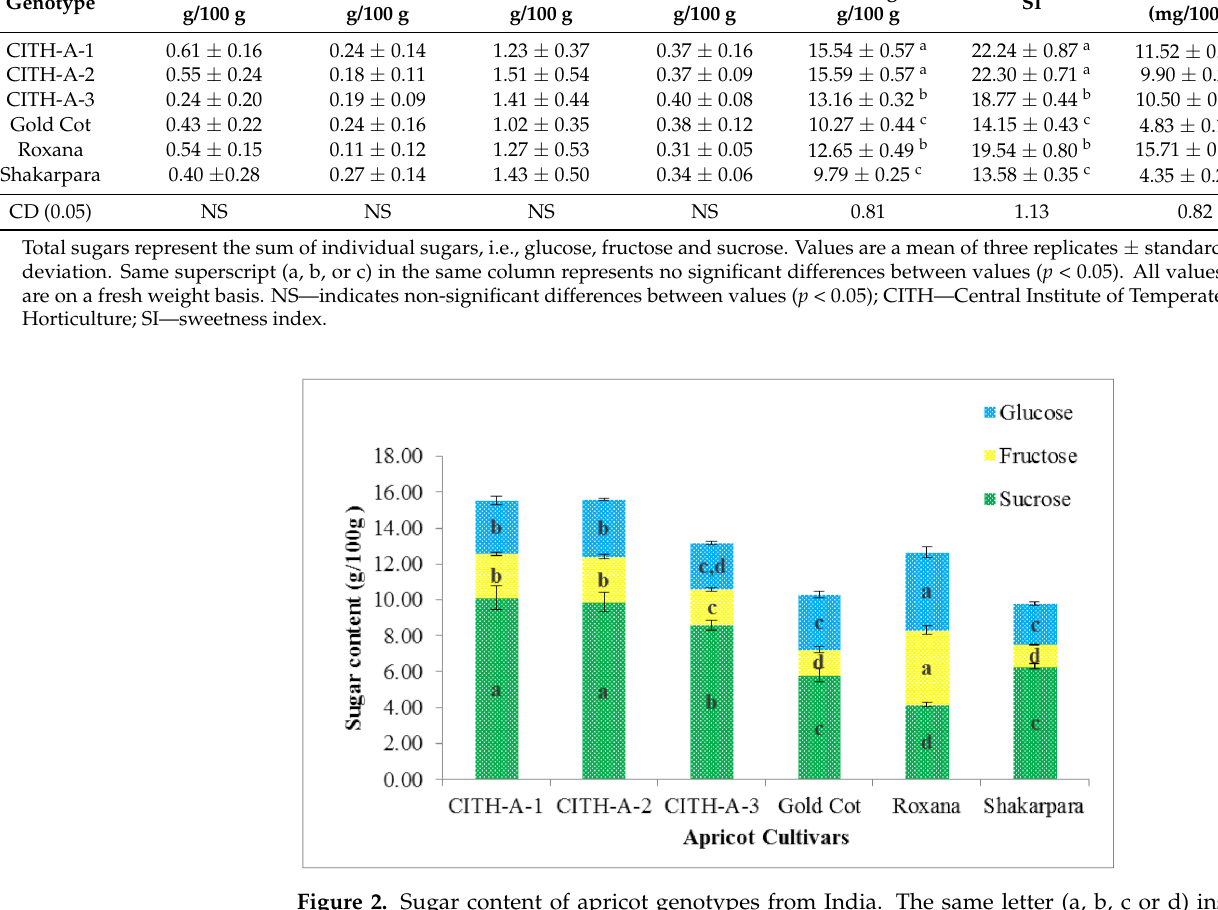
Figure 2. Sugar content of apricot genotypes from India. The same letter (a, b, c or d) inside a similarly coloured block indicates no statistically significant differences in values ( p <